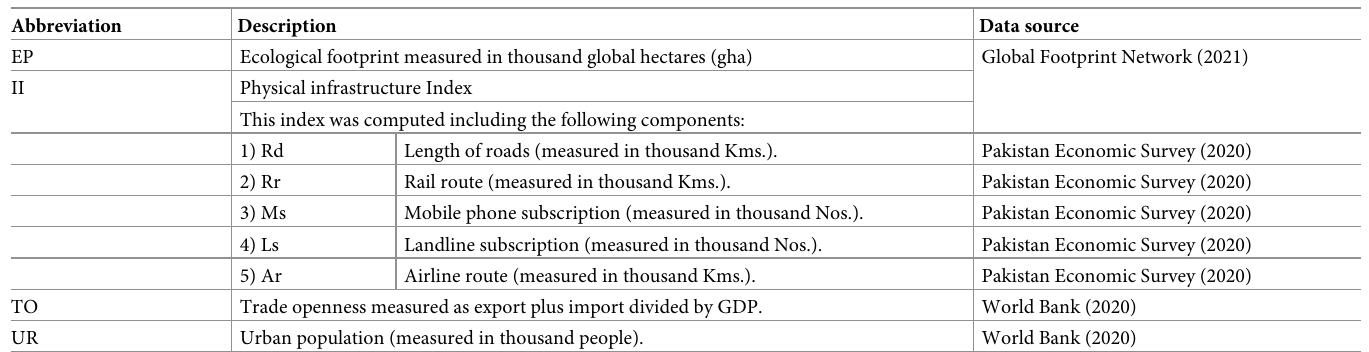
Table 1. Description and sources of the data